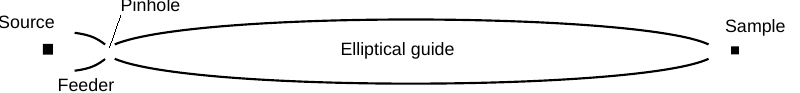
Figure 1. Schematic drawing of the elliptical single-pinhole guide, which does not break line-of-sight from the moderator. The figure is not to